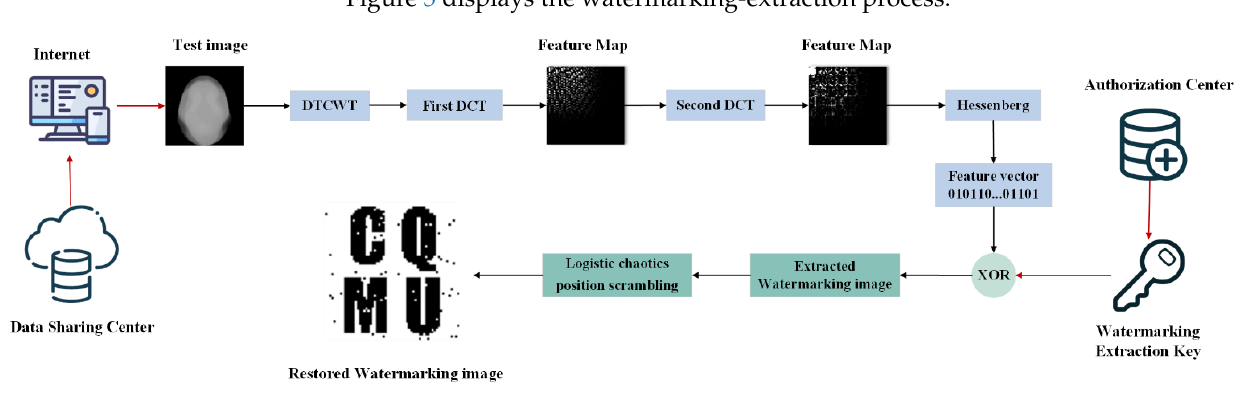
in Figure 6. The watermarking image of pixels 64 64 × in 0.6, 0